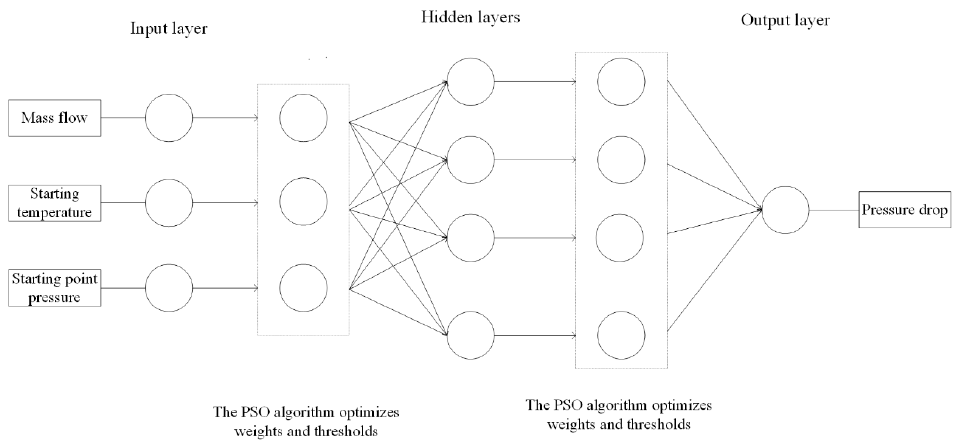
Figure 4. PSO-BP neural network pressure drop model. The PSO-BP pressure drop model flowchart is shown in Figure 5.